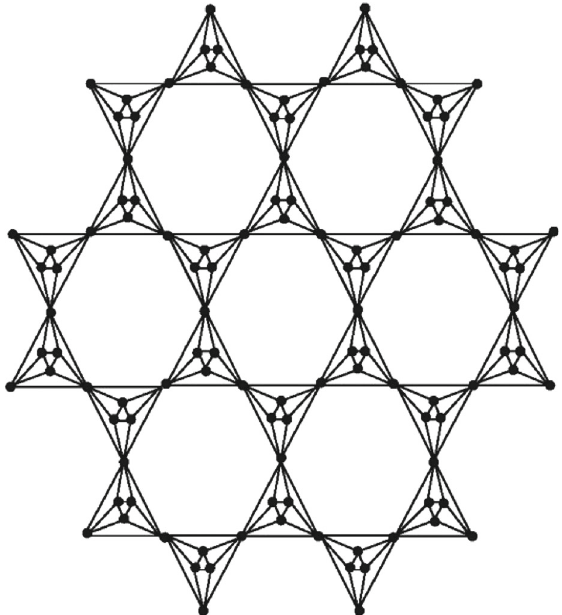
Figure 1: Planar octahedron